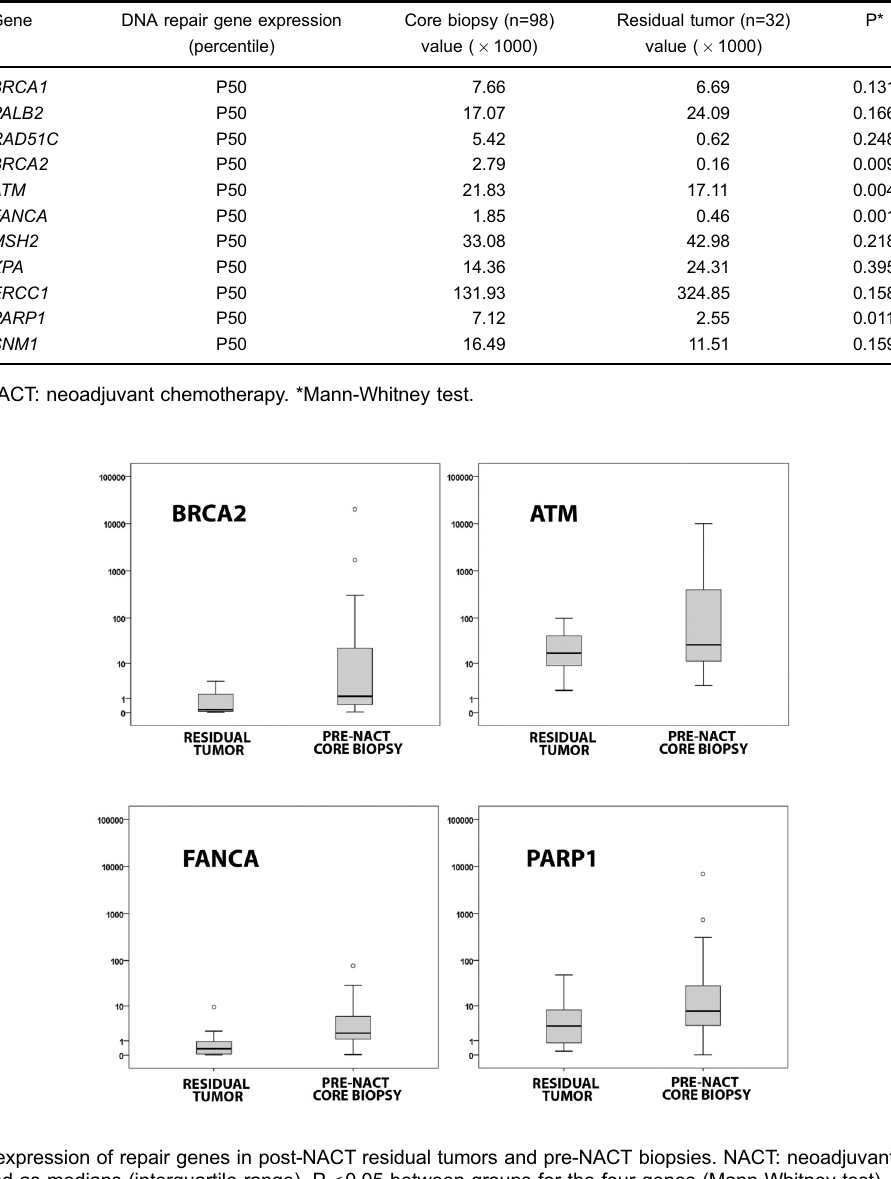
Figure 4. DNA expression of repair genes in post-NACT residual tumors and pre-NACT biopsies. NACT: neoadjuvant chemotherapy. Data are reported as medians (interquartile range). P o 0.05 between groups for the four genes (Mann-Whitney